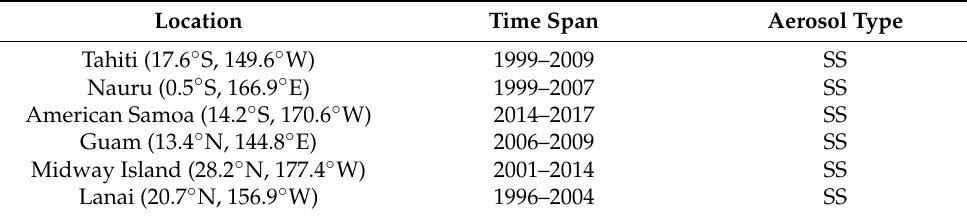
Table 1. The aerosol robotic network (AERONET) stations used for type identification.